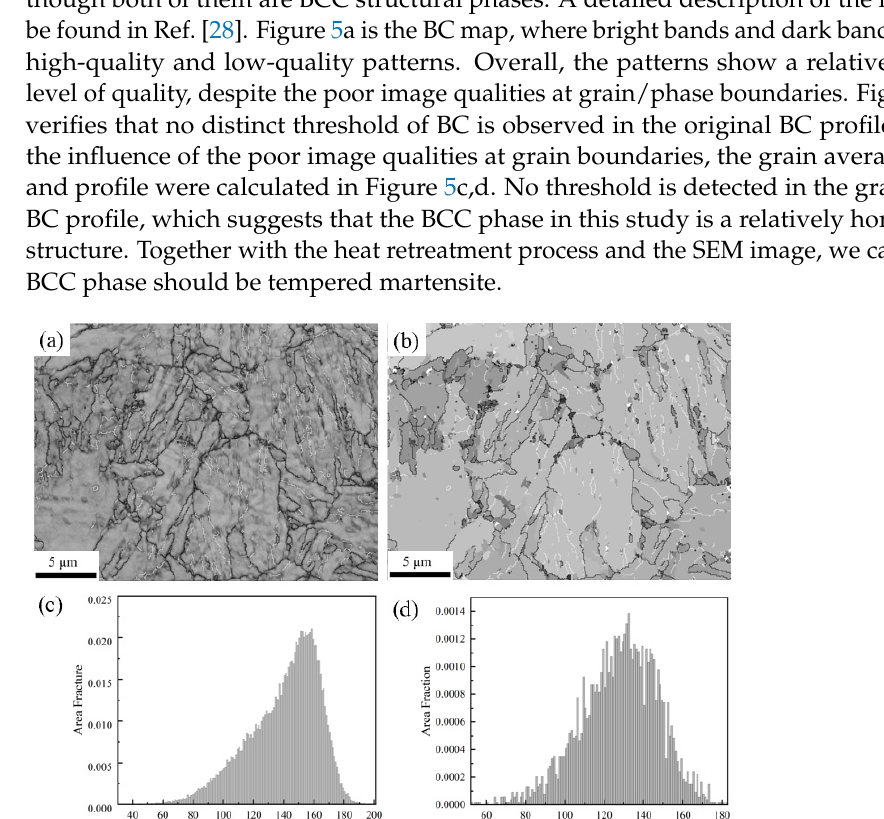
Figure 4. EBSD maps of the HSLA steel: ( a ) inverse pole figure (IPF) map; ( b ) phase map of ferrite (blue) and retained austenite (red); ( c ) correlated misorientation angle distribution between ferrite variants; and ( d ) correlated misorientation angle distribution between retained austenite.